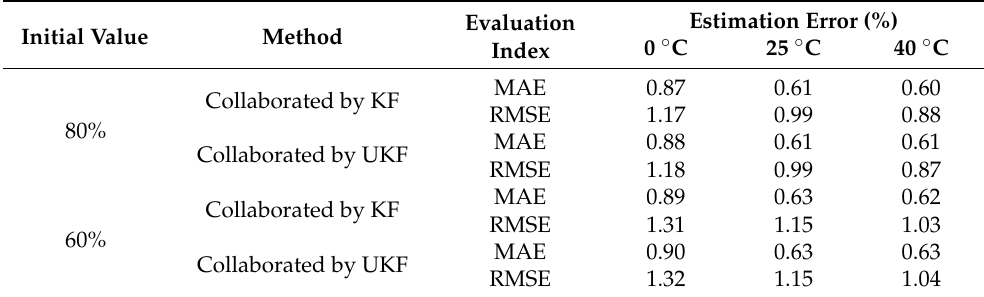
Table 3. RMSEs and MAEs of SOC estimation results with end-cloud collaboration system under different temperatures with incorrect initial value of 80% and